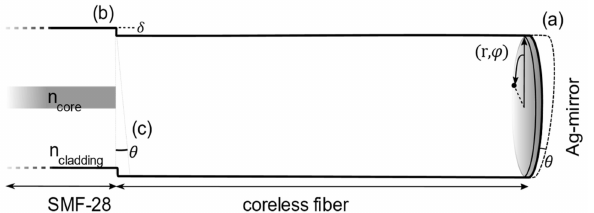
Figure 1. Schematic configuration of the challenges associated with the fabrication of fiberoptic interferometers based on core mismatch. The three parameters investigated are an end-face cleave angle ( a ), a lateral o ff set in the splice ( b ) and a tilted splice ( c ), as indicated in the figure.